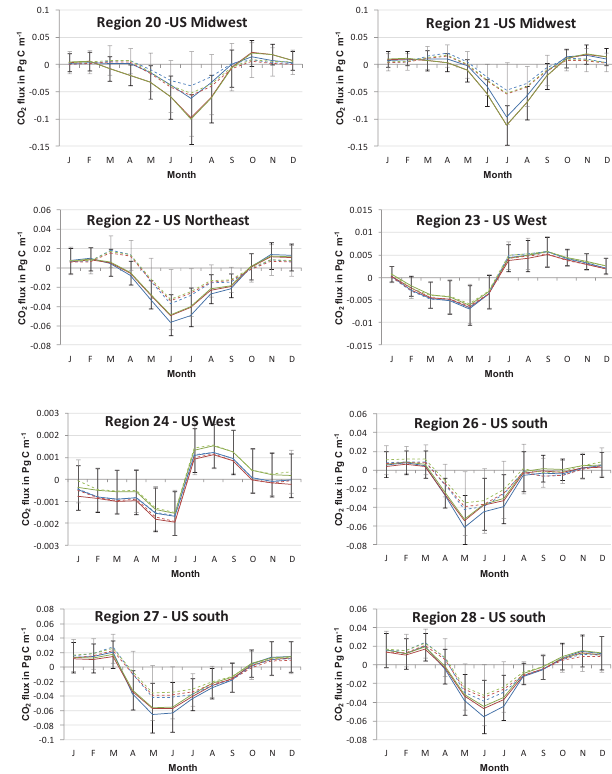
Figure 6. Monthly inverted (solid lines) and prior (dashed lines) CO 2 flux (negative values are sinks) averaged over 2002 to 2007 for Experiments 2 – annually varying terrestrial prior fluxes with (a) no adjustments – blue; (b) production adjustments – red; (c) crop production and consumption adjustments –